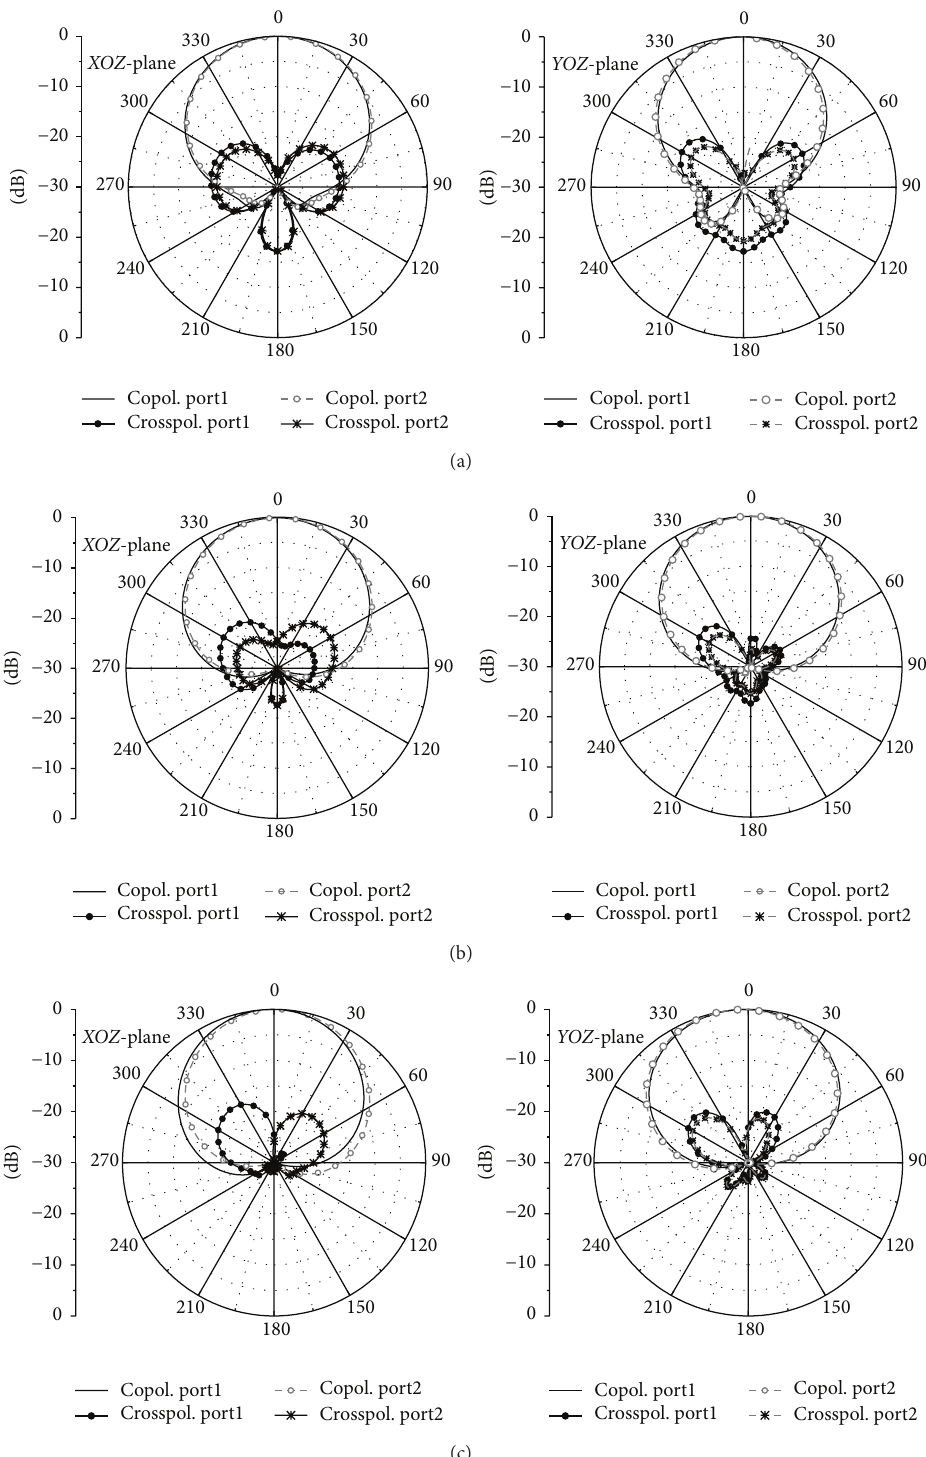
Figure 7: Measured radiation patterns for the proposed antenna at (a) 1.8 GHz; (b) 2.2 GHz; (c) 2.6